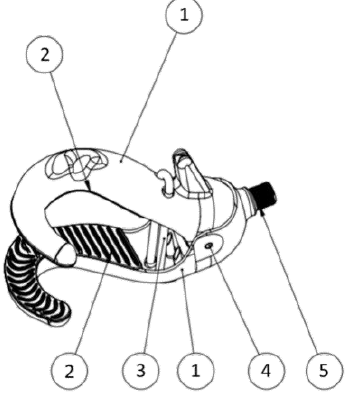
Figure 12. ( a ) Silicone rubber material with antibacterial properties (green). Pathway for obtaining the antibacterial silicone grip: ( b ) synthesis of nSi@AgNPs powder; ( c ) incorporation of nSi@AgNPs into the silicone matrix; ( d ) cured antibacterial silicone in the labsite; ( e ) antibacterial